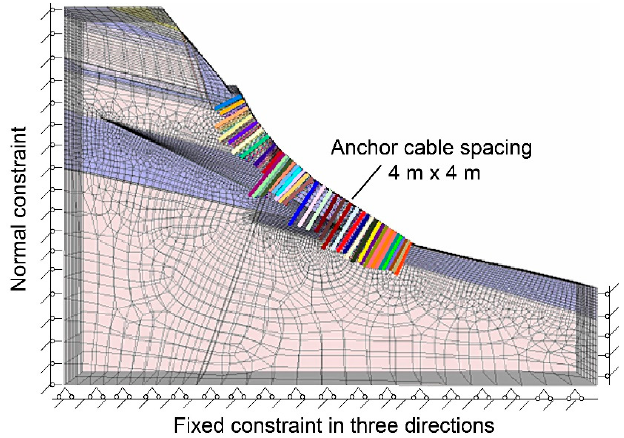
Figure 8. Reinforcement diagram in the numerical model.